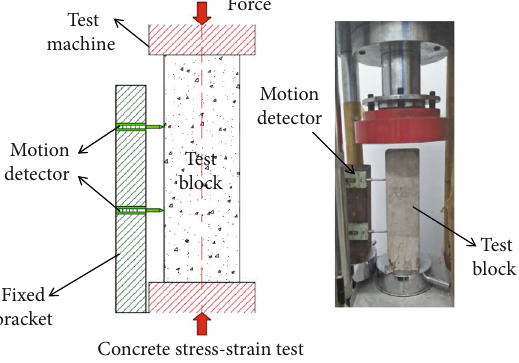
Concrete stress-strain Figure 4: Test of concrete